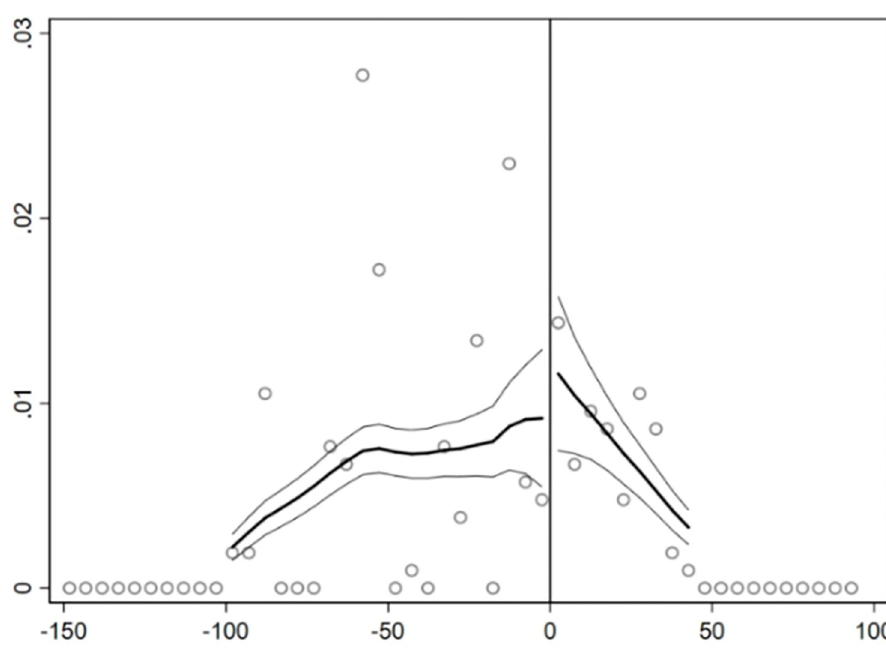
Fig 5. Distribution of running variable.